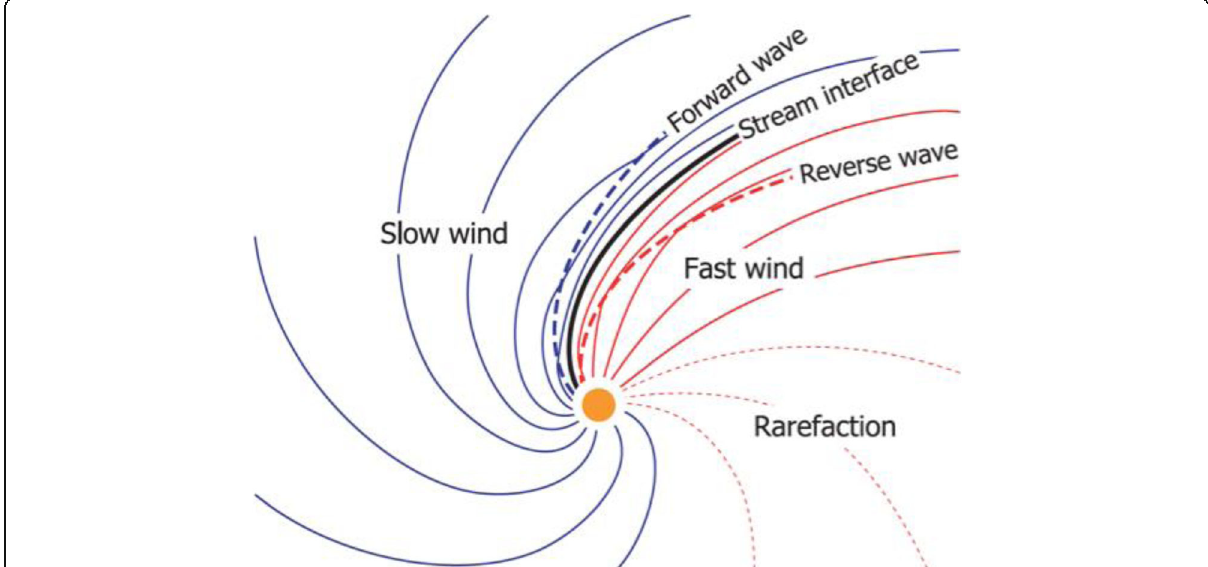
Fig. 30 Sketch of an SIR as seen in the ecliptic plane showing the fast (slow) solar wind in red (blue). The frozen-in magnetic field lines become aligned with the stream interface by the reverse (forward) wave. Taken from Owens and Forsyth (2013) adapted from Gosling et al.